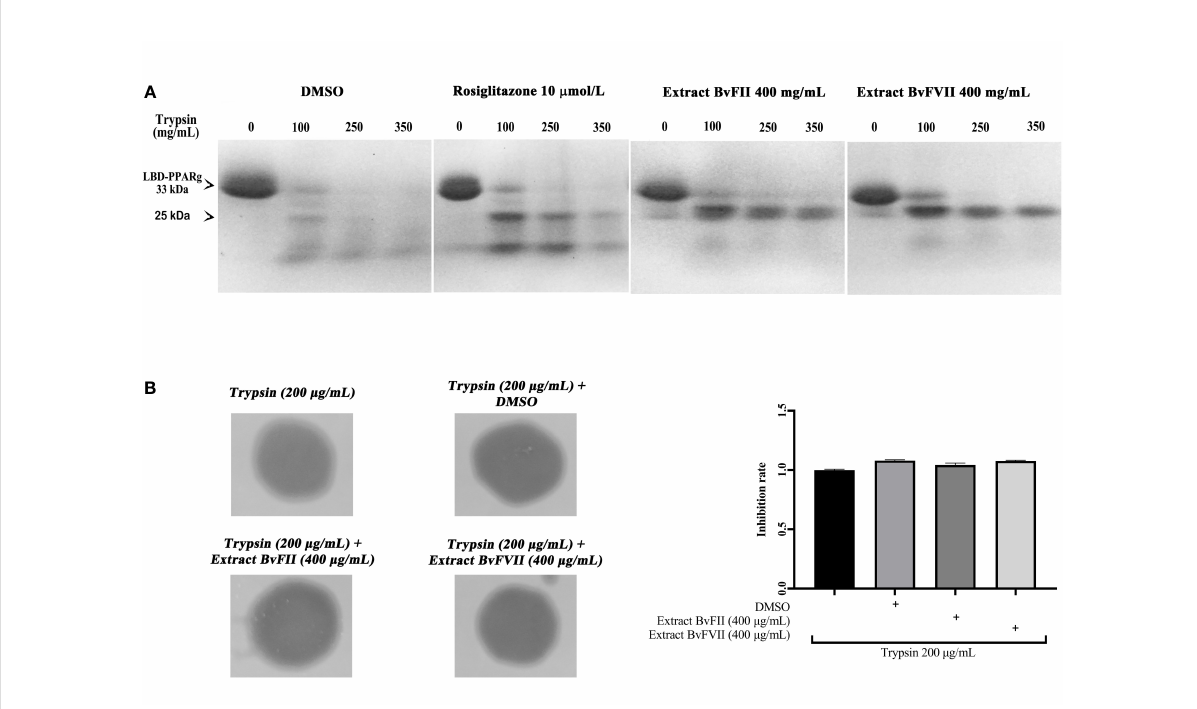
FIGURE 4 LBD proteolysis pattern of PPAR g by trypsin after treatment with different ligands. (A) Trypsin activity on PPAR g LBD was evaluated by using the recombinant protein his-LBD-hPPAR g , which was incubated with vehicle (DMSO), 10 µmol.L -1 rosiglitazone, fungus BvFII extract, or fungus BvFVII extract and with trypsin (0, 100, 250 and 350 m g.mL -1 ) for 60 minutes. LBD proteolytic patterns of PPAR g were analyzed by polyacrylamide gel electrophoresis under denaturing conditions, followed by staining the gel with Coomassie blue. (B) The proteolytic activity of trypsin on gelatin was evaluated after incubation of the enzyme with vehicle (DMSO) or with extracts of fungus BvFII (400 µg.mL -1 ) or fungus BvFVII (400 µg.mL -1 ). Polyacrylamide gel with 0.25% gelatin was left in contact with fi lter paper discs soaked in 20 µL of trypsin solution (200 µg.mL -1) for 1 h. Proteolytic patterns were analyzed by staining the gel with Coomassie blue. Dark areas show degraded gelatin. The quanti fi cation of the inhibition rate of vehicle and extracts BvFII and BvFVII is shown on the right. The data presented represent the mean ± standard deviation of the mean. The statistical test applied was the analysis of variance (one-way ANOVA) followed by the Newman-Keuls multiple comparison test, with no statistically signi fi cant